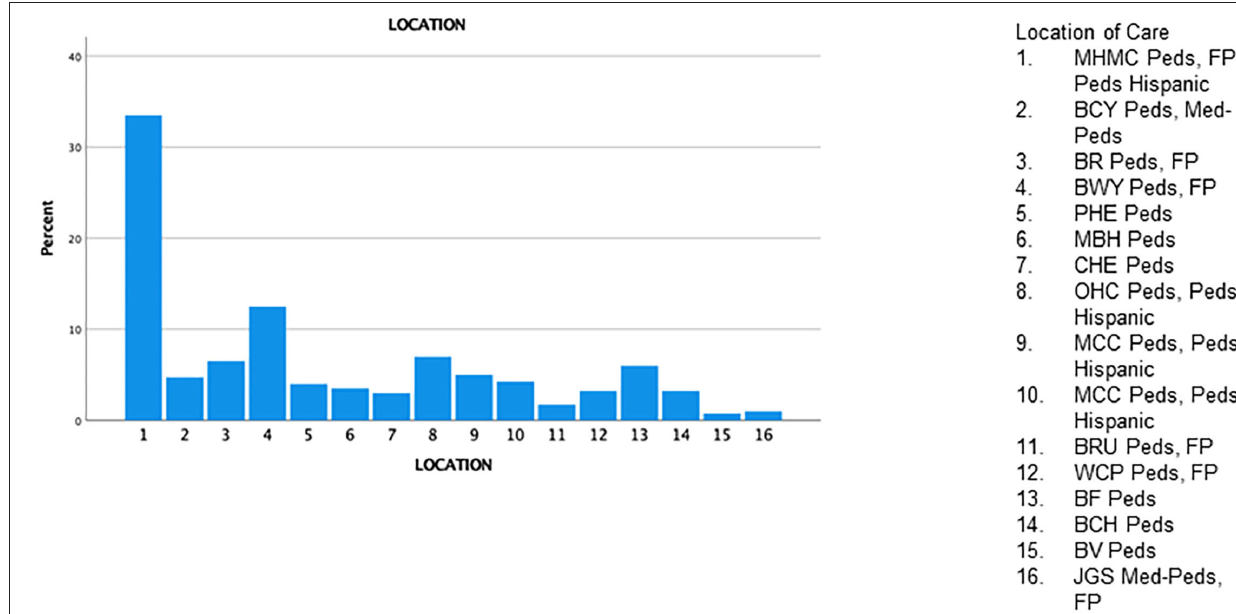
FIGURE 3 | Pediatric clinic locations.